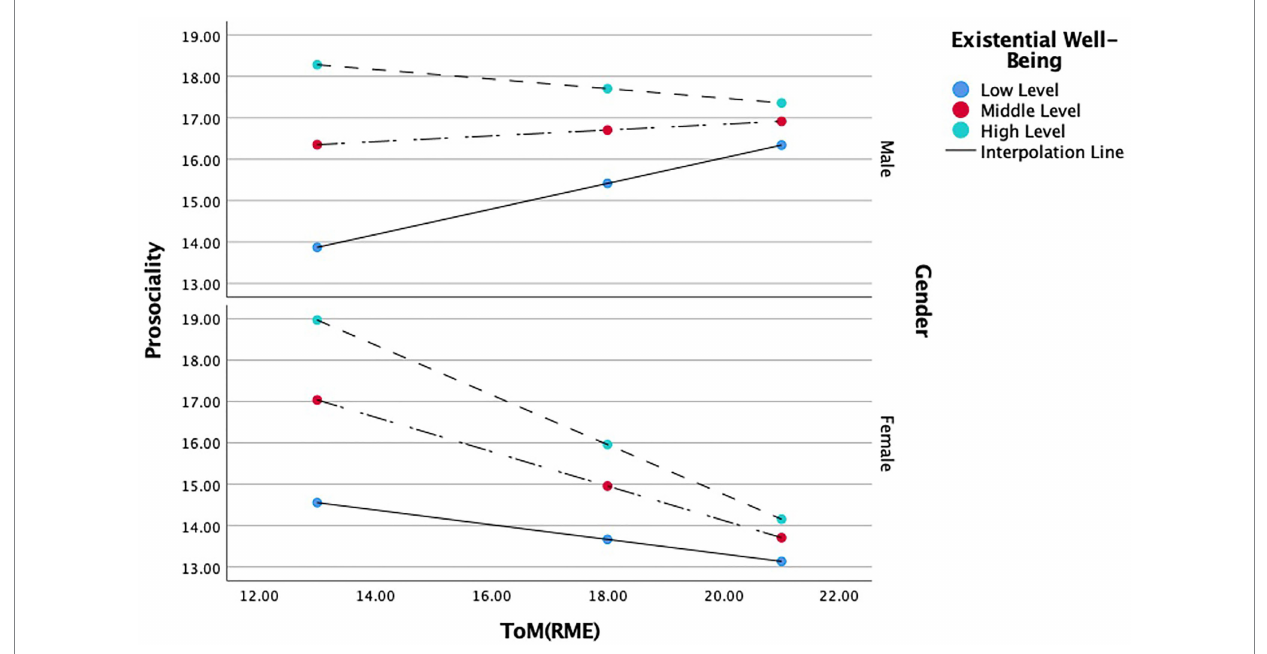
FIGURE 1 Moderating role of existential well-being and gender in the relationship between ToM and